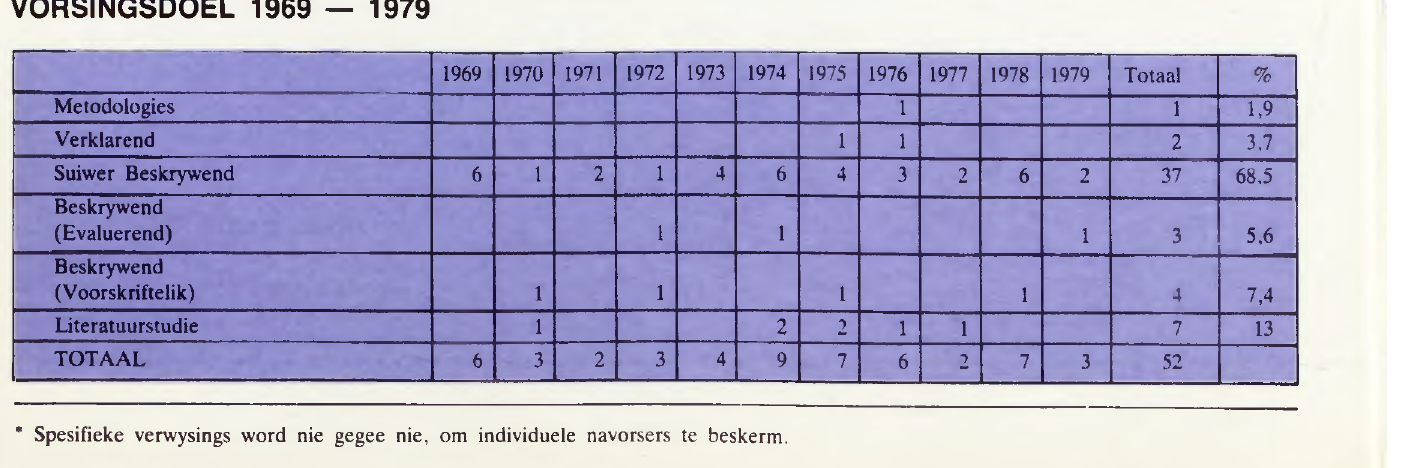
TABEL 4 DIE HOEVEELHEID NAVORSINGSAKTIWITEIT IN VERPLEEGKUNDE VOLGENS NA­ VORSINGSDOEL 1969 —